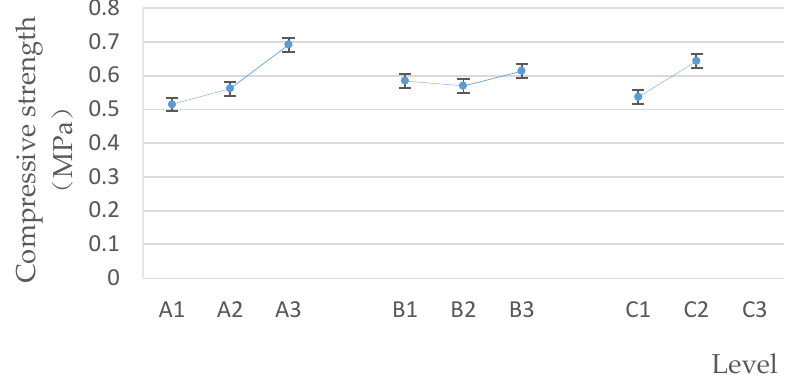
Figure 5. Factors and levels–compressive